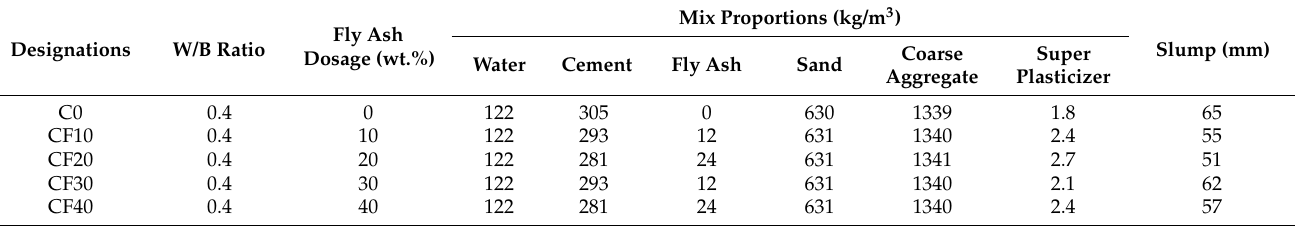
Table 2. Mix proportion of face slab